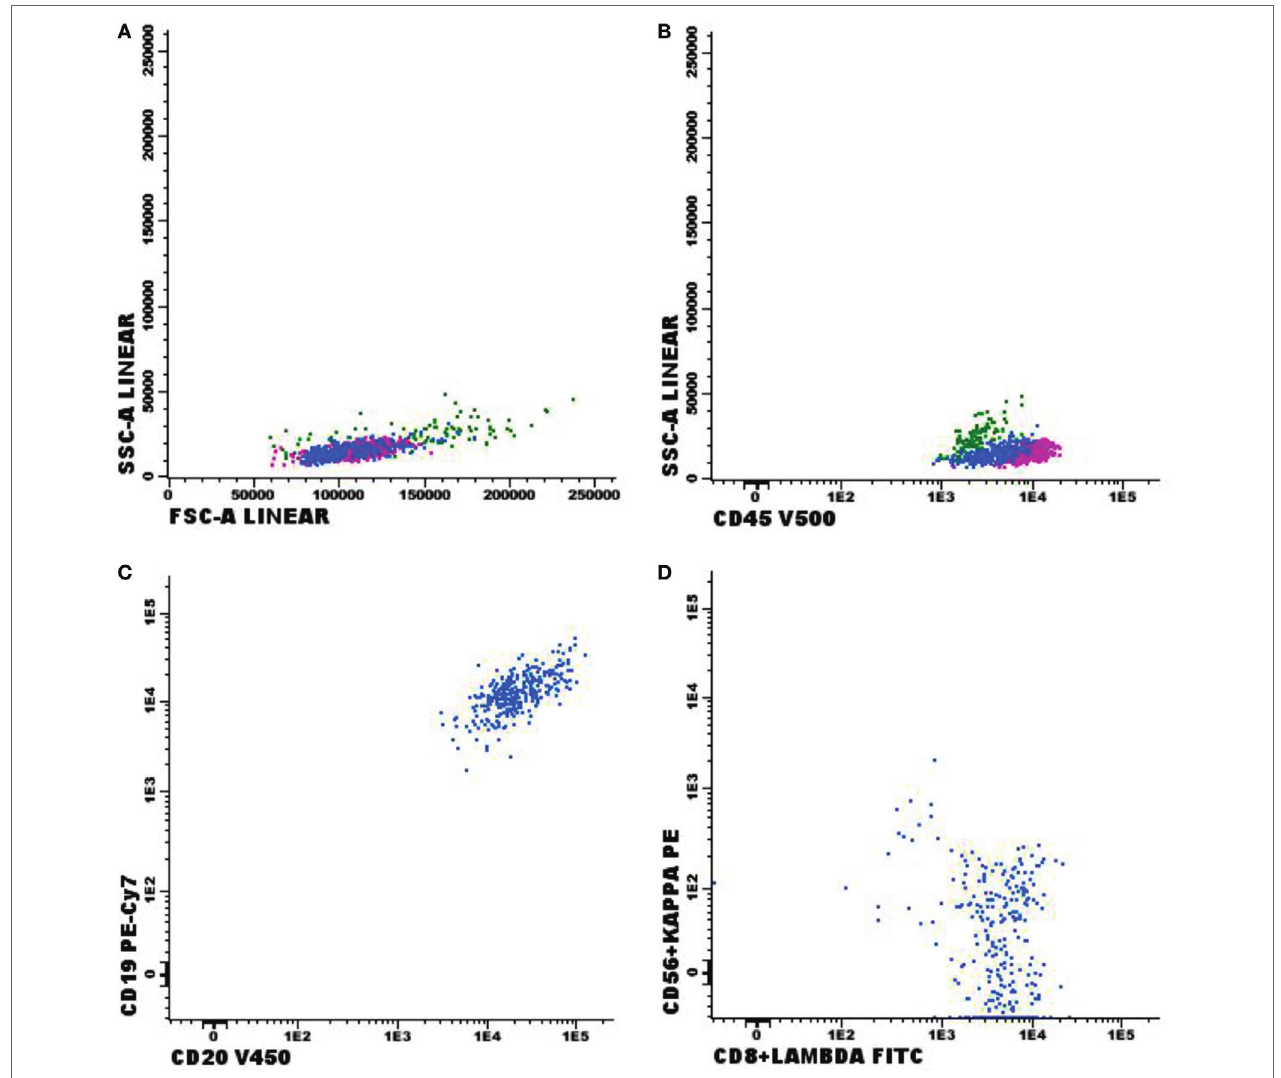
FigUre 2 | Flow cytometry results of suspected central nervous system infiltration by B-cell non-Hodgkin lymphoma. Presumptive diagnosis: B-cell non-Hodgkin lymphoma. (a,b) Normal forward-scattered light (FSC size) and side-scattered light (complexity—SSC); (c) mature CD19 + and CD20 + B-lymphoid population; (D) mature monoclonal lambda-light-chain-expressing B-lymphoid population. Sample collected in Transfix ® /ethylenediaminetetracetic acid with an approximate volume of 5 ml and 2 leukocytes/mm 3 and 0 red blood cells/mm 3 . Samples with 8,575 events acquired in Canto II (Becton Dickinson) and analyzed using the Infinicyt software (Cytognos). Frequency of populations in the viable cell region and CD45 + cell (1,000